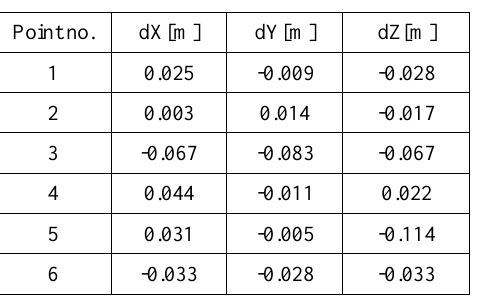
Table 3. Comparison between photogrammetric and tachymetric determination of displacement vectors at positions of displacement control points (Tachymetric points minus photogrammetric points). Displacement vector comparison shows that